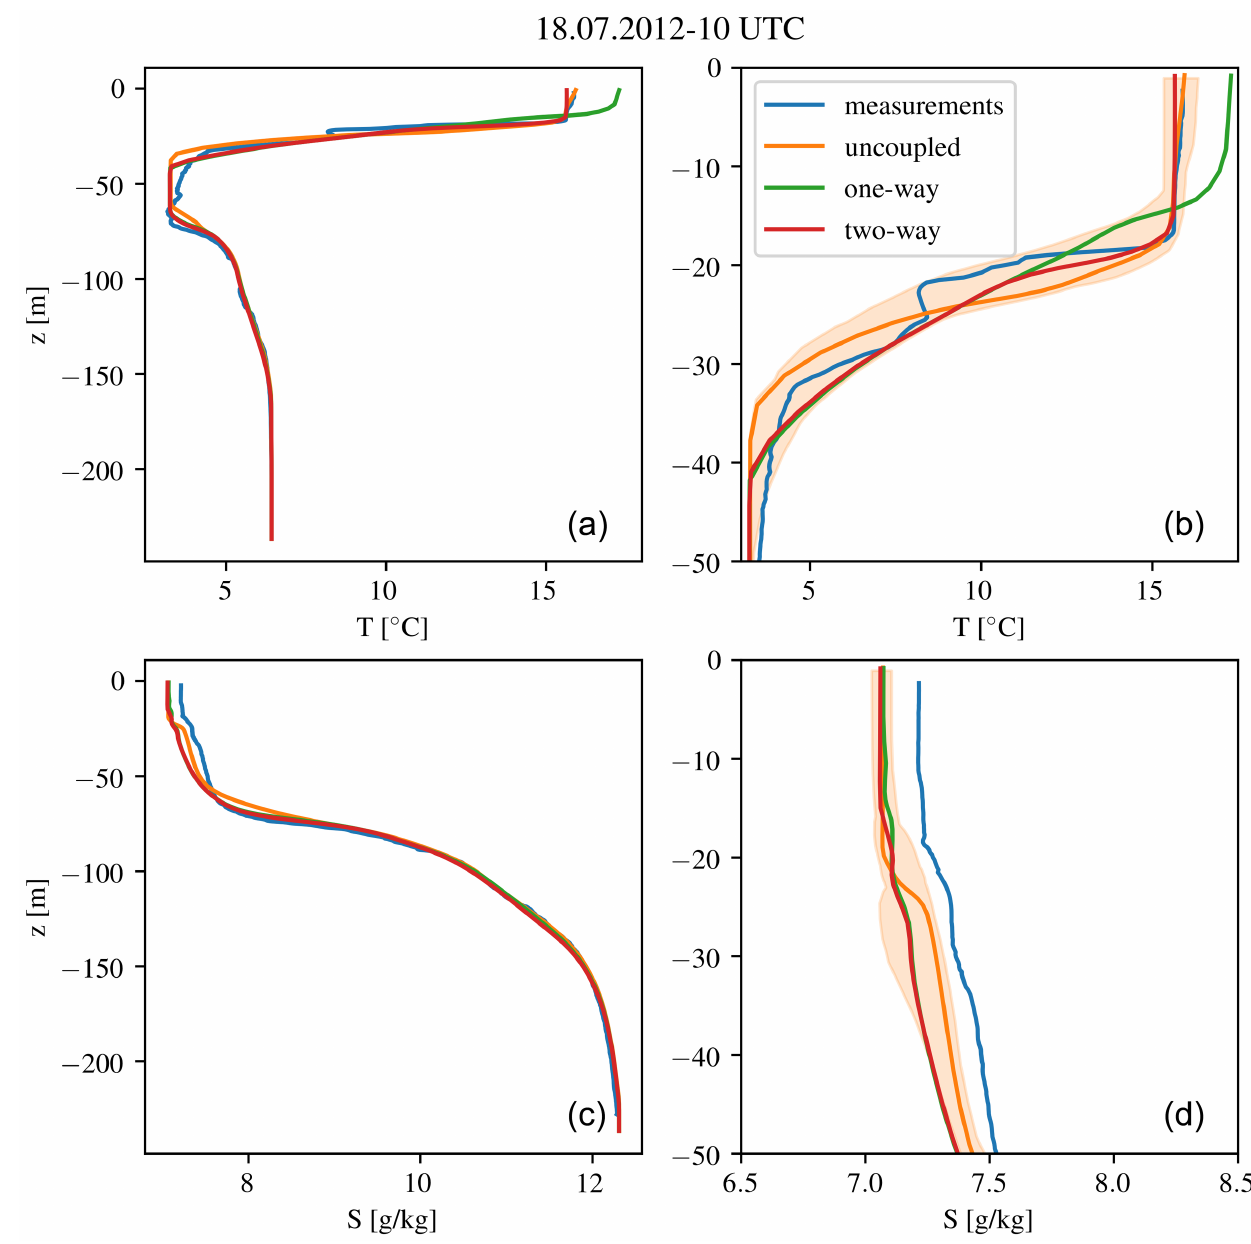
Figure 15. Temperature and salinity profiles at station TF271 from CTD measurements and the three model simulations. Panels (a) and (c) depict the whole water column; (b) and (d) are a zoom towards the sea surface. The light-orange-shaded area depicts the variability of the uncoupled simulation within an 8d interval (14–21 July